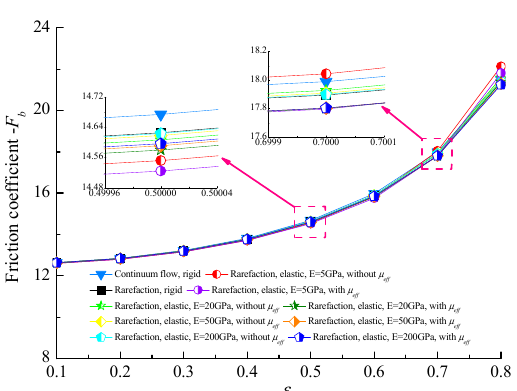
Figure 6. Relationships between the static friction coefficient and the eccentricity ratios for different elastic moduli at Λ = 30 and υ = 0.3.